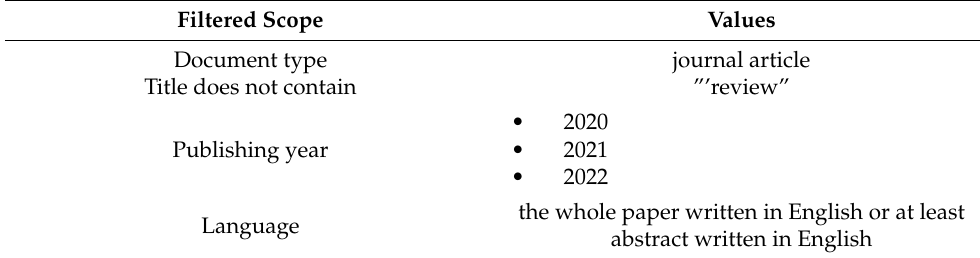
Table 2. The list of criteria used for